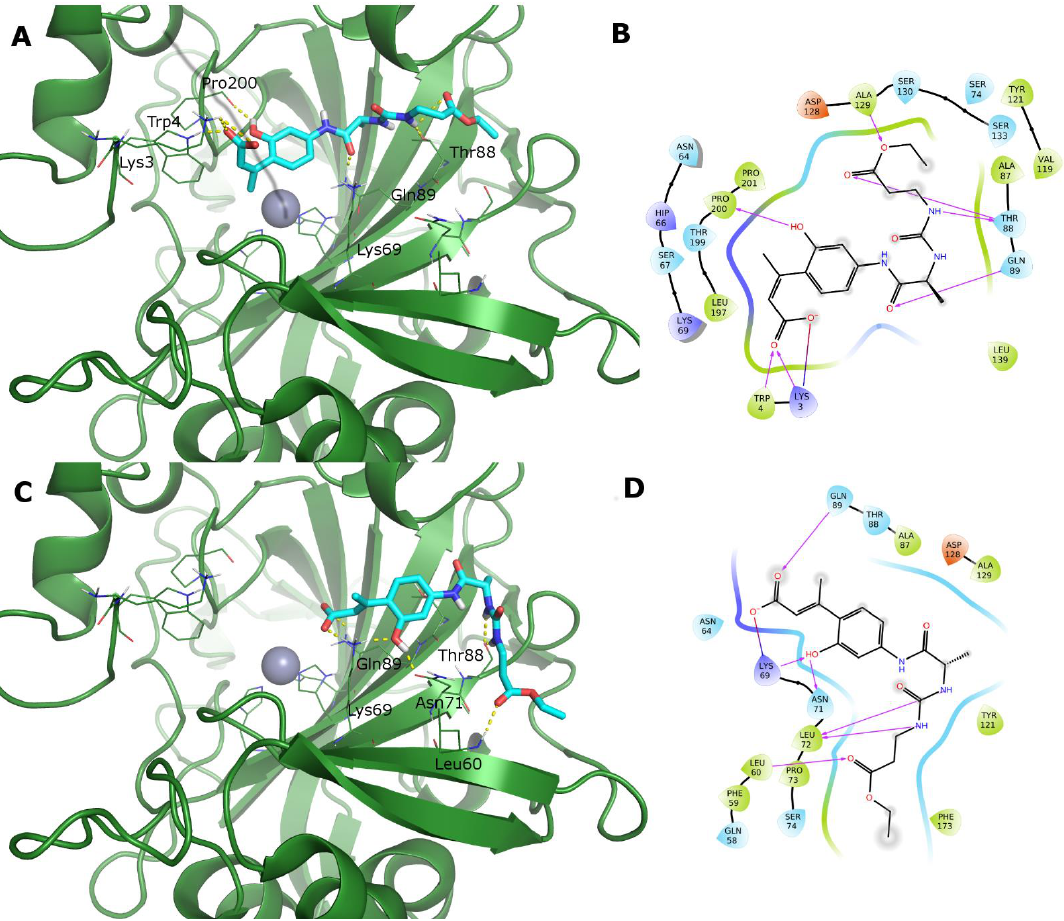
Figure 2. Docked poses of ligand 19 (stick, cyan C atoms) in the Z (panel ( A )) and E (panel ( C )) hydrolyzed forms complexed to hCA XII (dark green cartoon). The most relevant residues are represented as lines. Corresponding 2D ligand interaction diagrams are reported in panels ( B , D ), respectively. To further validate our prediction, the most conserved docked pose of compound 19 , as the hydrolyzed Z -form, in the hCA XII binding site was submitted to MD simulation to verify its stability and reliability. A 100 ns MD simulation was carried out where the protein maintains a stable conformation (maximum RMSD 2.00 Å , Figure 3), while the ligand slightly moves from the above-described docked pose and reaches a stable geom- etry throughout the simulation as well, apart from a short conformational rearrangement at 27.4 ns where the ligand urea function loses its interaction with Thr88 to form two in- tramolecular H-bonds with the β -Ala carbonyl group.